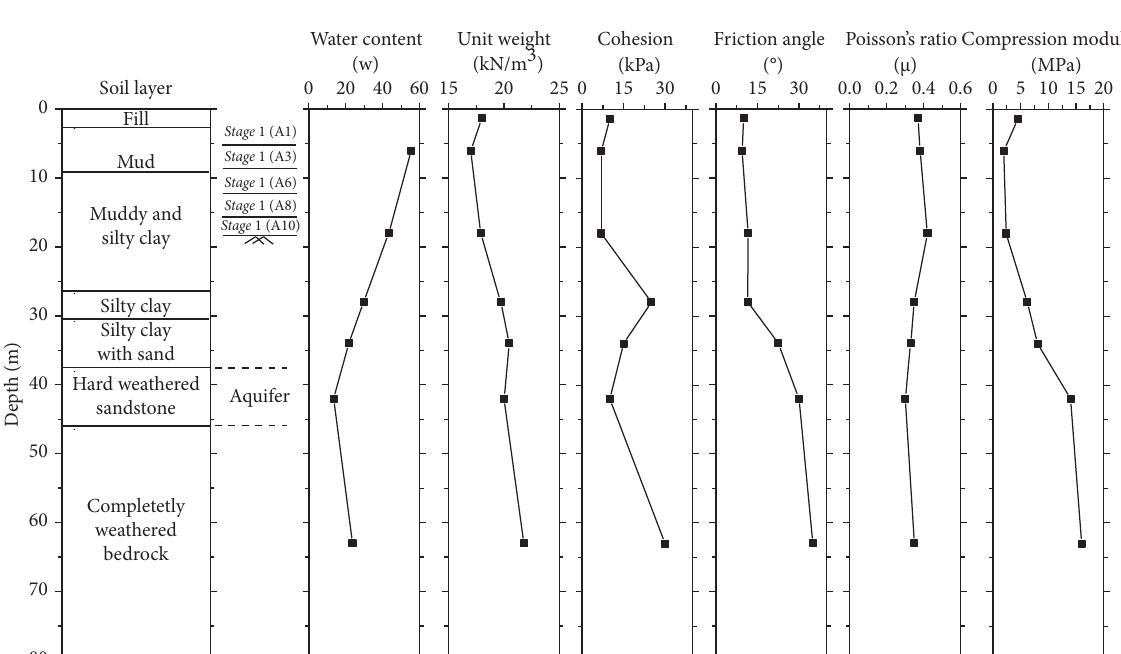
Figure 5: Soil profiles and material